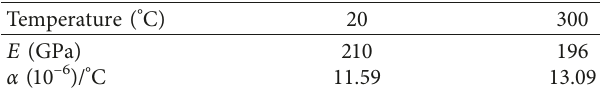
Table 3: Thermophysical properties of 45